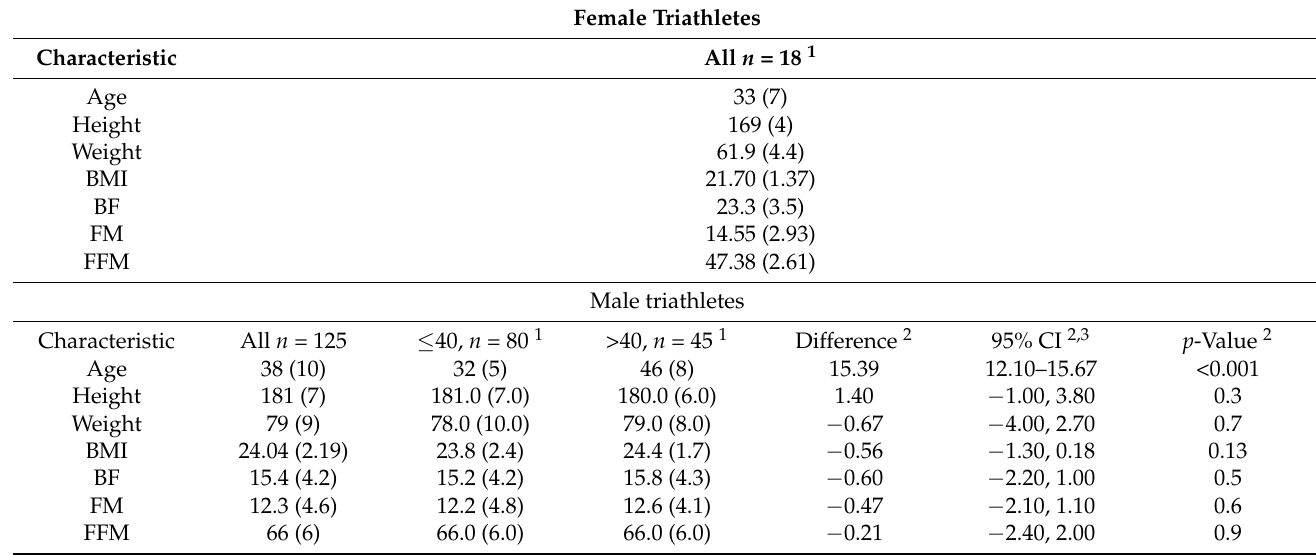
Table 1. Population characteristics for males and females, including characteristics of the age groups ≤ 40 and >40 years of age in males and the mean differences between them.